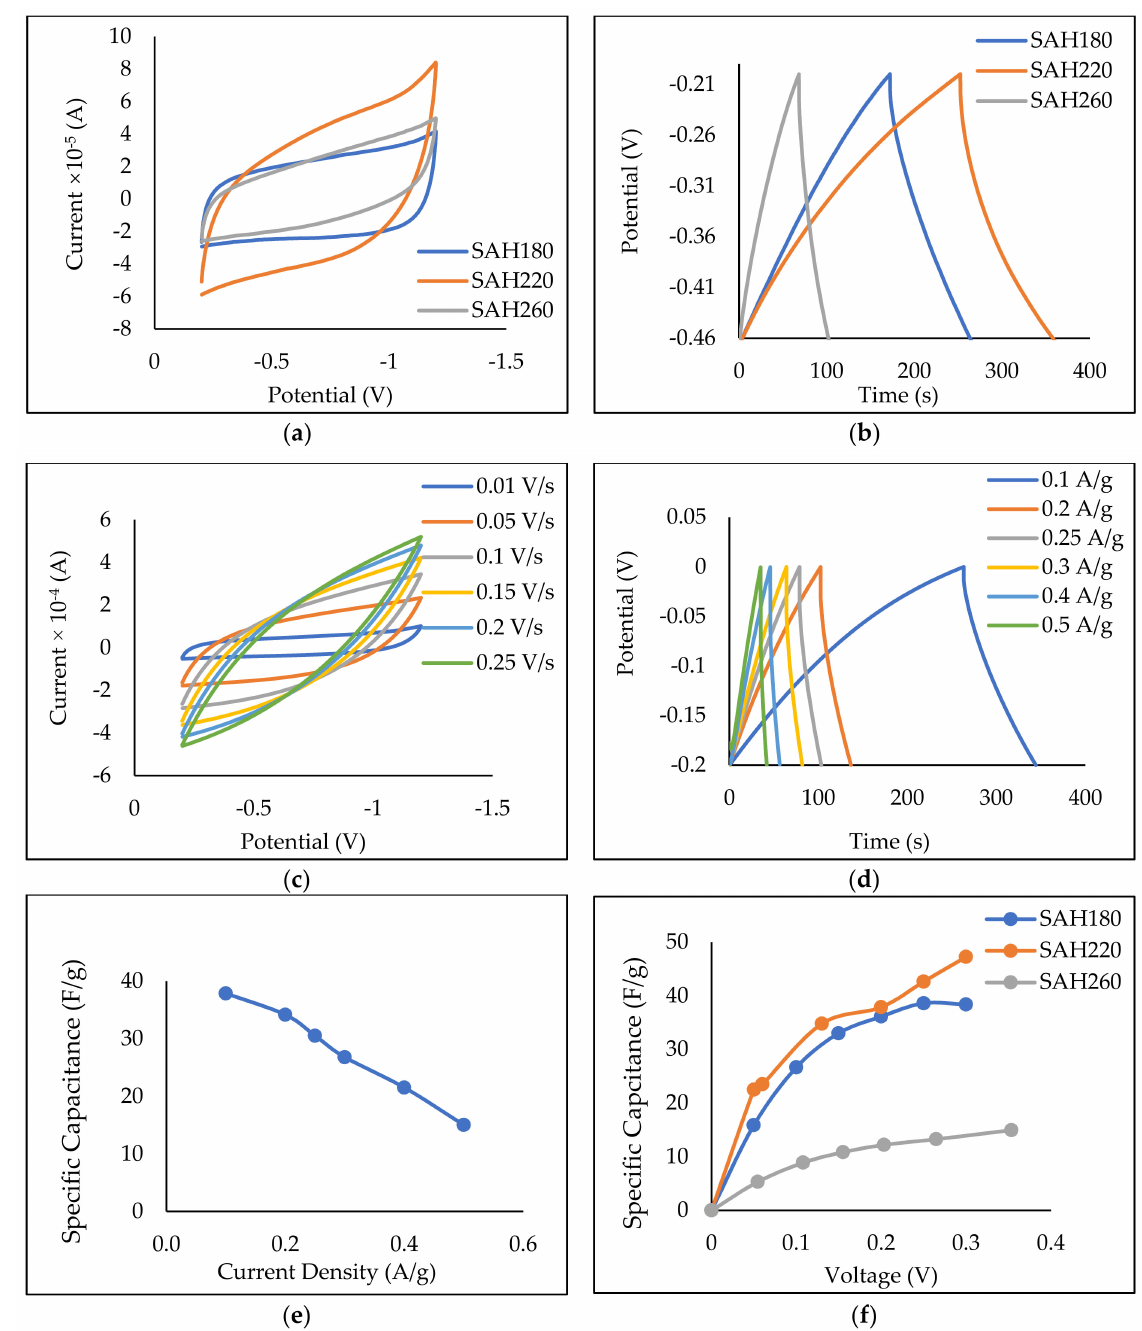
Figure 6. ( a ) Cyclic Voltammograms for SAH 180, SAH220, SAH260, ( b ) Galvanostatic charge and discharge Curve for SAH180, SAH220, SAH260, ( c ) Cyclic Voltammograms for SAH 220 at 0.01–0.25 V/s, ( d ) Galvanostatic Charge − discharge Curve for SAH220 at 0.1 − 0.5 A/g, ( e ) Specific Capacitance vs. Current Density for SAH220, ( f ) Adsorption Model for SAH180, SAH220, SAH260. Galvanostatic Charge and Discharge (GCD) experiments were performed at 0.1 A/g with − 0.5 V to 0.25 V potential window, with all three systems resulting in